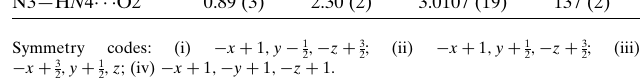
Table 2 Experimental details.